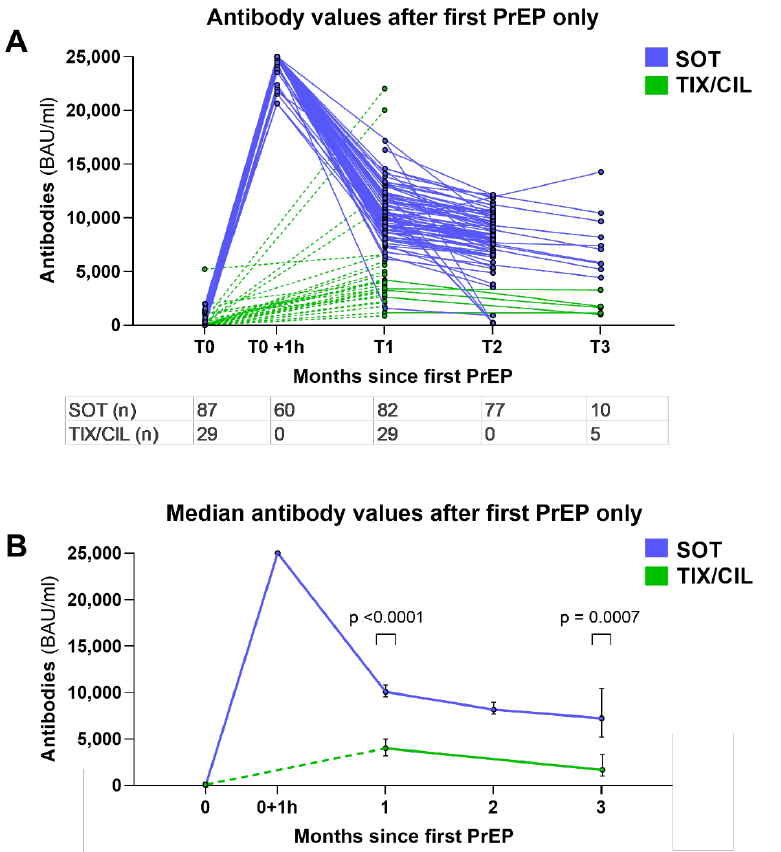
Figure 2. Graphs displaying the measured antibody values after first PrEP (before administration of any further PrEP), separated by time point. ( A ) shows all values after first PrEP, with SOT and TIX/CIL respectively. Each line represents a patient. The table shows the number of measurements available at each time point. ( B ) shows the median values of A. Error bars show 95% confidence interval. Mann–Whitney U test was used to compare the values at T1 and T3. T0 +1 h contains antibody values measured 1 h after SOT infusion, which could not be obtained for TIX/CIL due to delayed release after intramuscular injection. Dashed lines symbolize the inaccurate representation of pharmacokinetics in this case. BAU = binding antibody units; mL = milliliter; PrEP = pre- exposure prophylaxis; SOT = sotrovimab; TIX/CIL = tixagevimab/cilgavimab; T0–T3 = time points of measurements, roughly equal to months since first